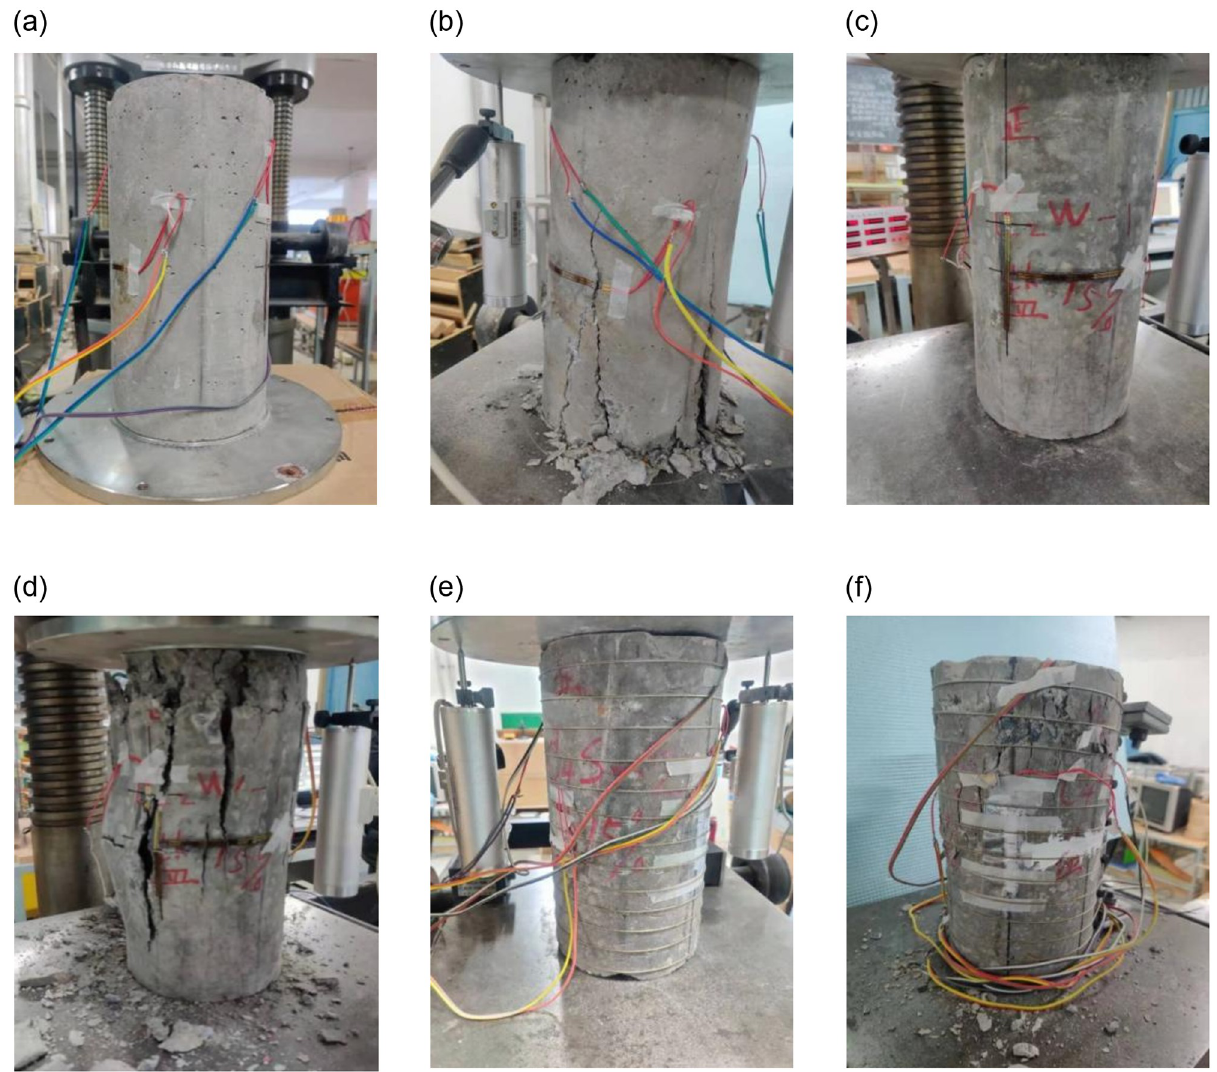
Fig 6. Reinforced concrete specimens before and after the test. (a) C1W-1 Before test. (b) C1W-1 After test. (c) C2W-1 Before test. (d) C2W-1 After test. (g) C3S-1 Before test. (h) C3S-1 After